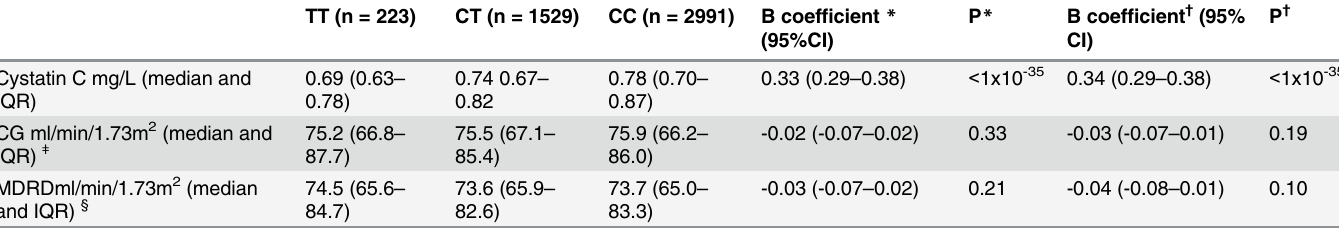
CG, creatinine based eGFR according to the Cockroft-Gault formula; MDRD, creatinine based eGFR according to the modi fi cation of diet in renal disease formula. Linear regression analyses, the beta-coef fi cient denotes the difference of standardized values of LN-transformed cystatin C, CG and MDRD per each copy of the coded (major) allele of rs13038305 in additive models.